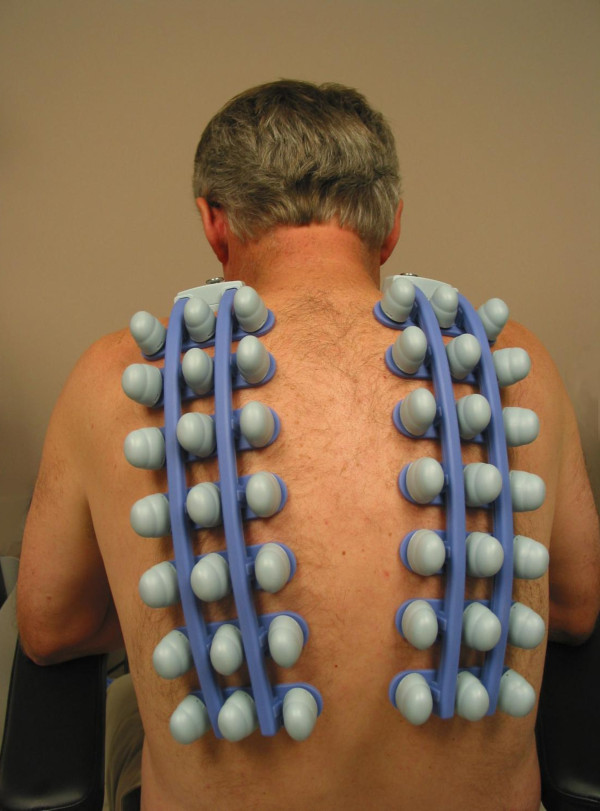
Vibration response imaging system: the energy generated by the vibrations of the lungs during inspiration and expiration is discerned by two arrays of piezoelectric sensors during 12 seconds of recording. Written informed consent was obtained from the patient for publication of the accompanying image.